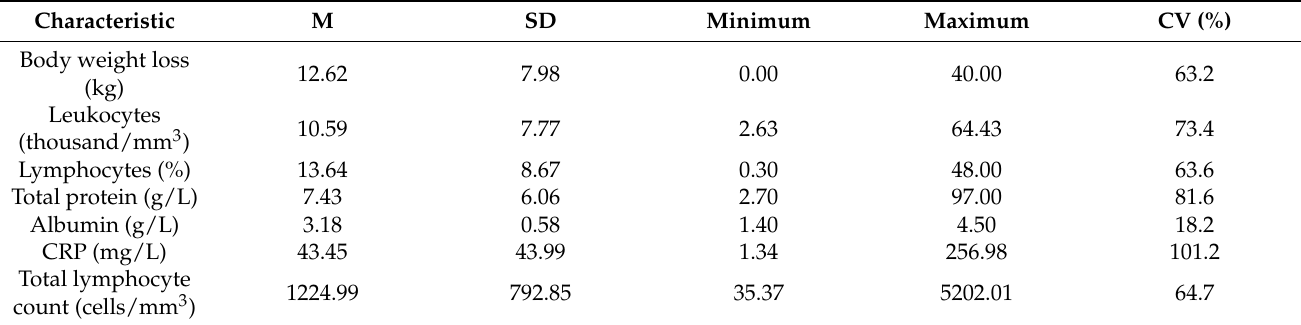
Table 3. Body weight loss and laboratory data of HNC patients ( n = 224).